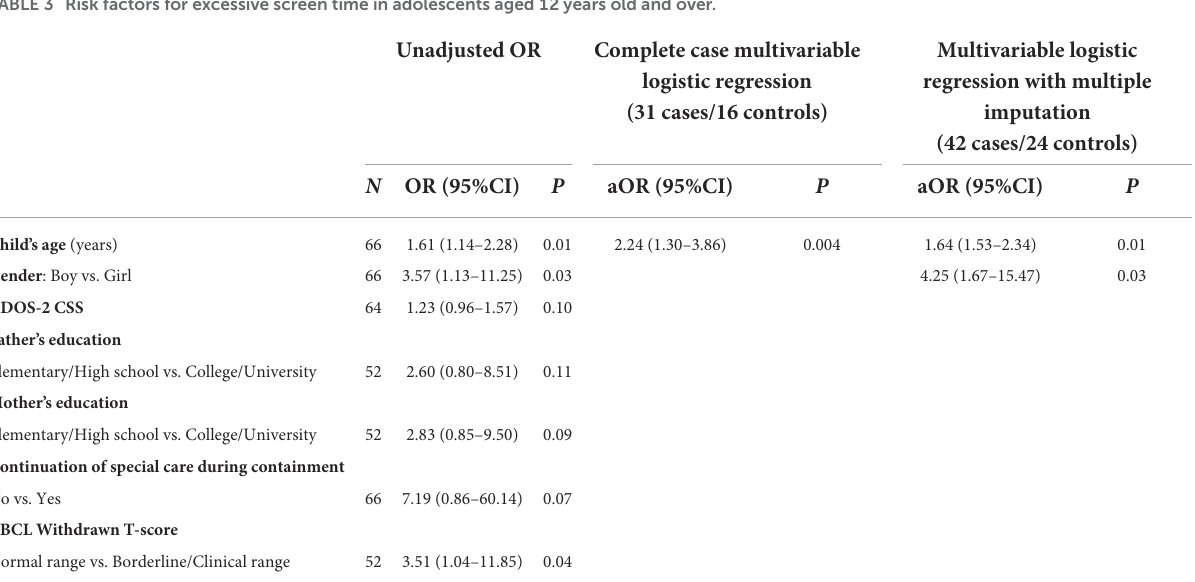
TABLE 3 Risk factors for excessive screen time in adolescents aged 12 years old and